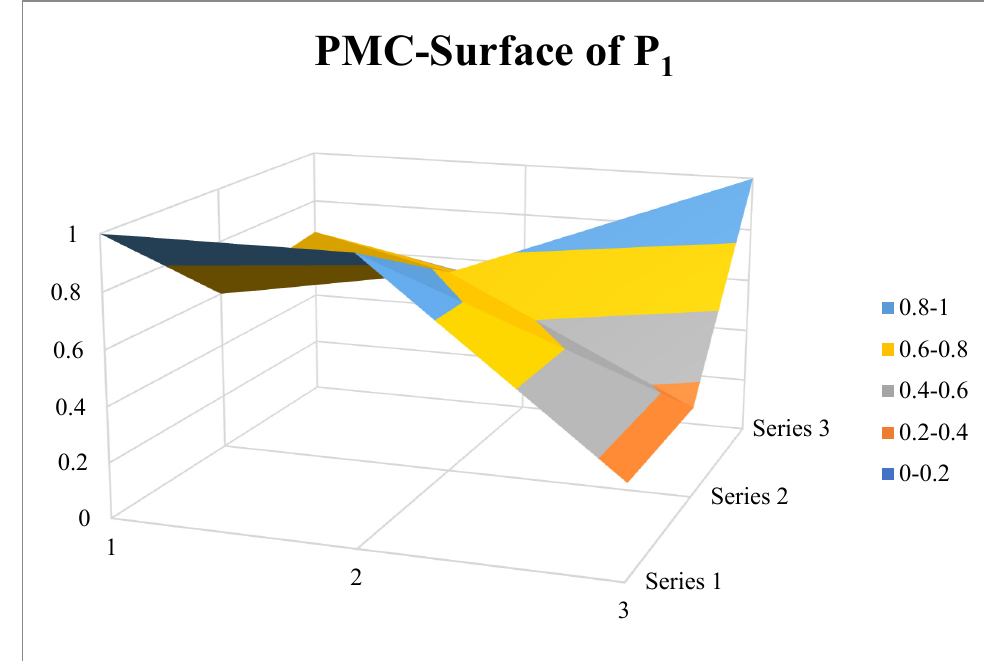
Figure 7. PMC-Surface of P 1 .